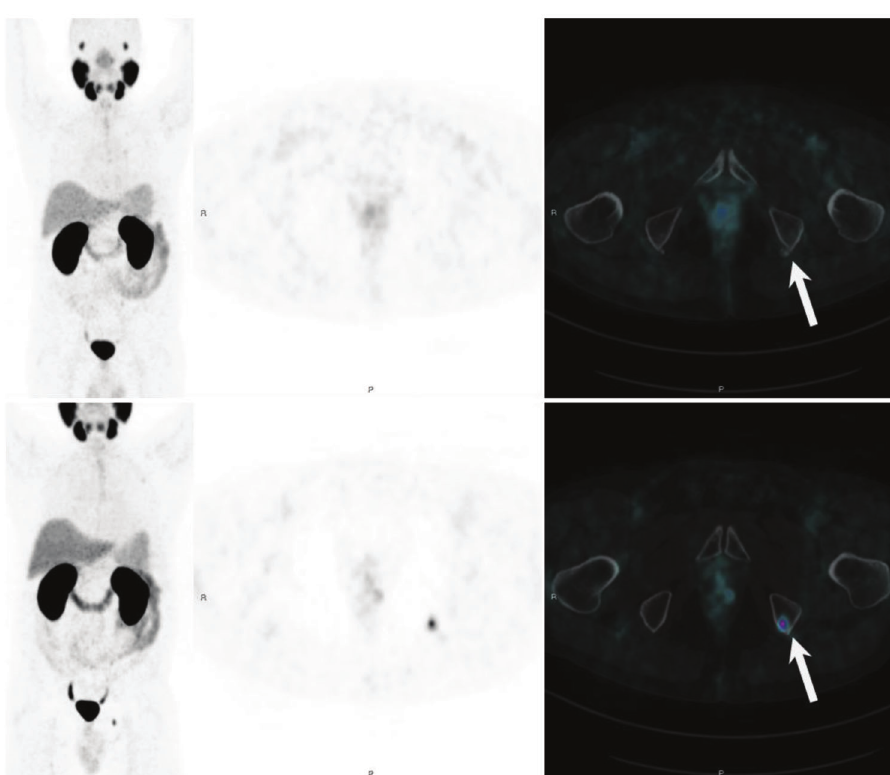
Figure 4 - PSMA PETshowing long-term PSMA expression against ADT in a patient with recurrent PCa who previously underwent pelvic radiation. The bottom row shows a bone metastatic lesion in left ischiatic tuberosity. The top row shows a new PSMA PET scan performed 10 months after beginning ADT, with resolution of the molecular expression of PSMA, probably reflecting a therapeutic effect of